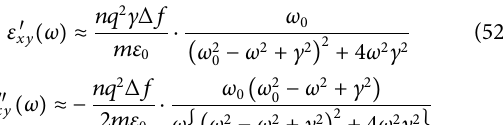
Figure 4B . Angular distribution of electrons for L z (cid:1) ± 1 is considered p -electron-like and can be expressed as p ± (cid:1) ip p x ± y expressing right-hand rotation and